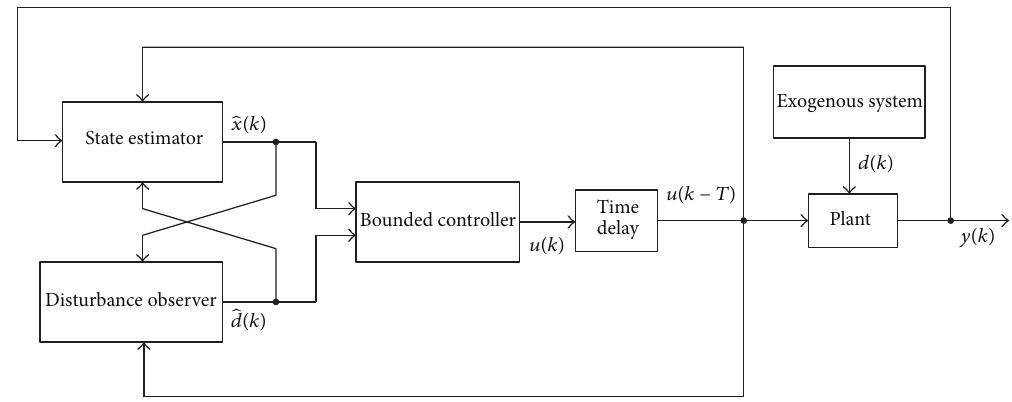
Figure 1: The control diagram of